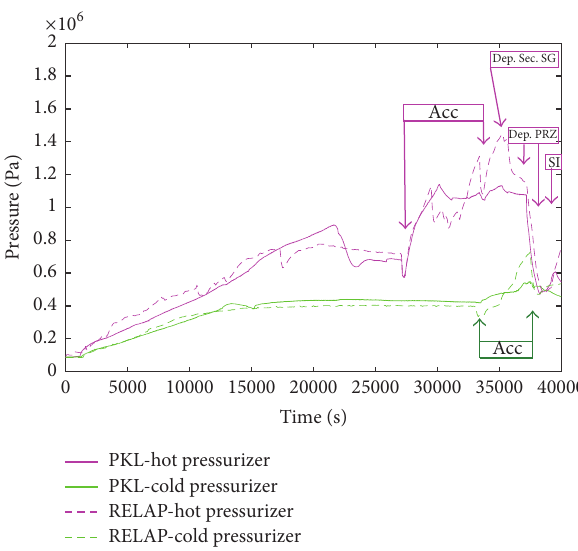
Figure 11: Primary pressure PKL versus RELAP5. Temperature influence (Phase II).